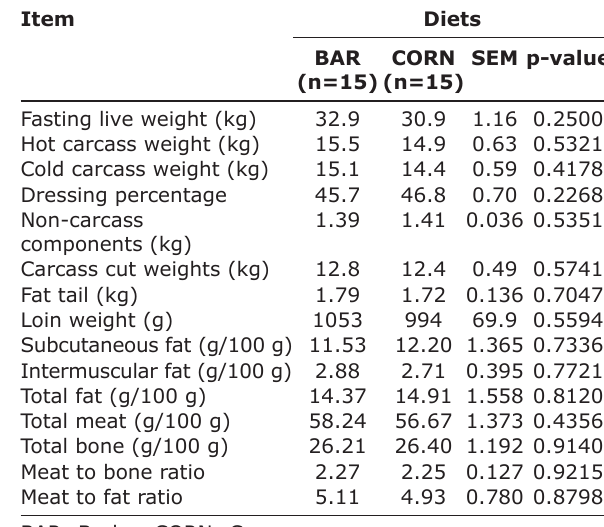
Table-5: Effects of feeding either BAR or CORN grains on carcass, non-carcass components, carcass cut weights and percentages, and dissected loin of Awassi